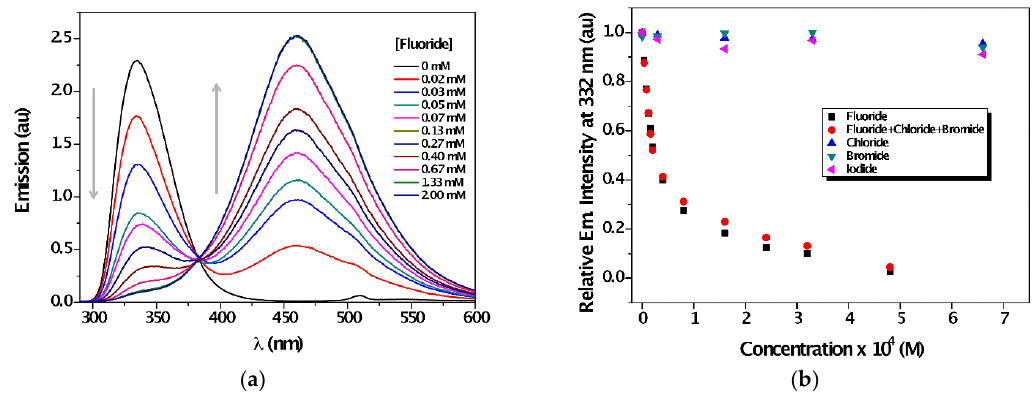
Figure 4. ( a ) Emission spectra of 1 ( c = 0.04 mM, λ exc = 252 nm) in the presence of increasing amounts of F¯ ( c = 0, 0.02 mM → 2 mM) in acetonitrile; ( b ) Changes in the emission at 332 nm upon titration with different halides.